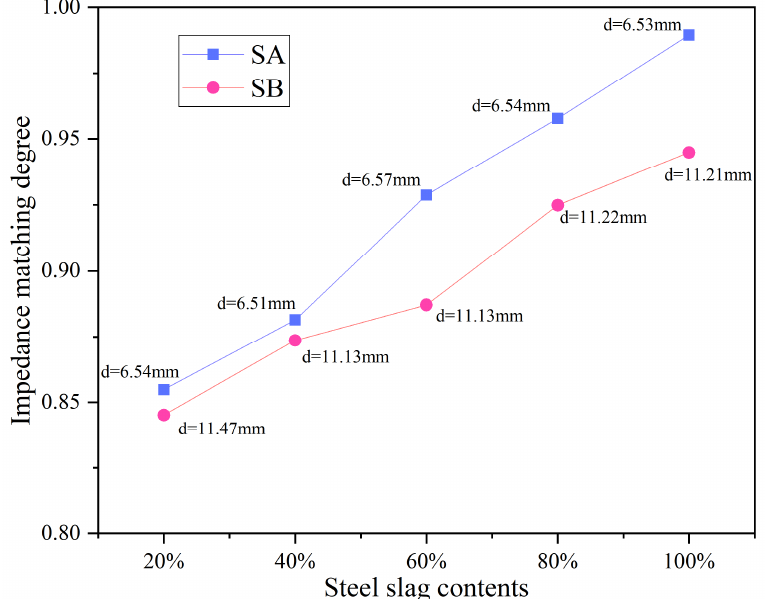
Figure 11. The effect of steel slag contents on the electromagnetic wave reflectivity of asphalt mixtures.